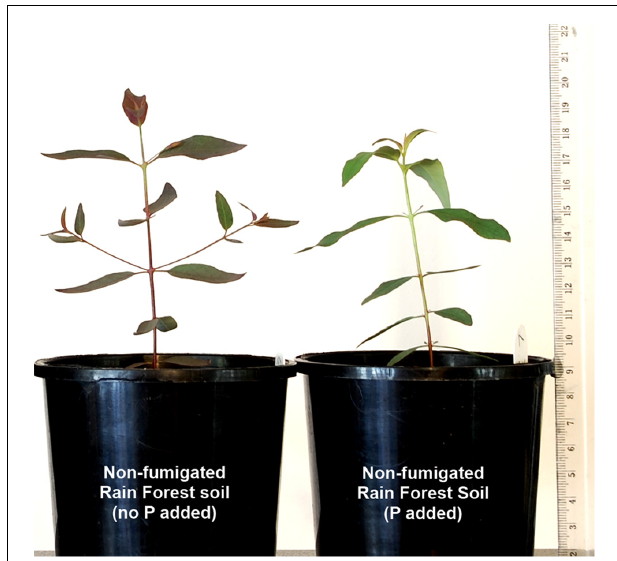
FIGURE 2 | Examples of Eucalyptus grandis seedlings grown for 146 days after transplant (DAT) to non-fumigated rain forest soil without or with phosphorus (P) addition. P deficiency in the non-fertilized seedling (left) is indicated by conspicuous purple leaf coloration (see Dell, 1996) in comparison to the green leaves of the P-fertilized plant (right) .